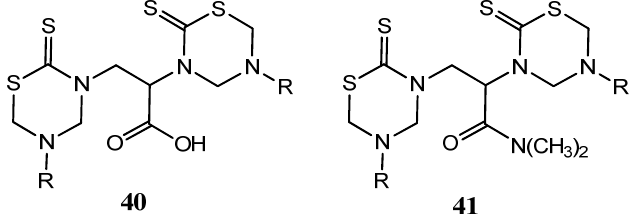
Figure 15. 2,3- bis (5-Alkyl-2-thiono-1,3,5-thiadiazin-3-yl)propionic acids 40 and their corresponding N,N -dimethylpropionamides 41 tested as antibacterial and antifungal compounds.